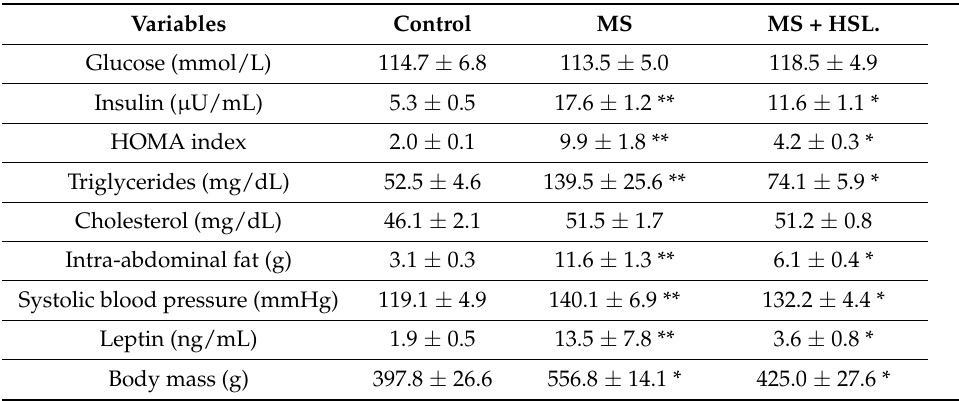
Table 1. General characteristic of experimental groups. Variables